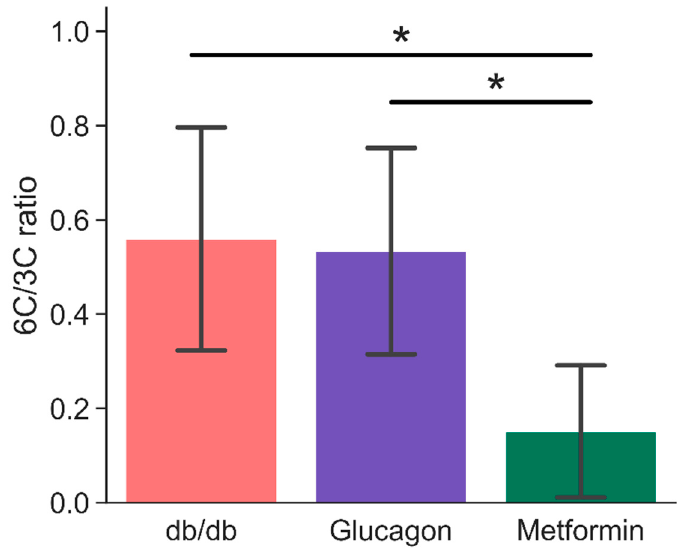
Figure 4. Ratio of signal intensities of six-carbon (glucose-6-phosphate and glucose—both α - and β -isomers) to three- and four-carbon (glyceraldehyde-3-phosphate, phosphoenol pyruvate, glycerol, glycerol-3-phosphate, lactate, and malate) resonances. Signal intensities were obtained by fitting a mixed Gaussian/Lorentzian shape to resonances in the sum spectra (shown in Figure 2). * indicates statistical significance ( p < 0.05). Error bars are standard deviation. n = 6 ( db/db ), 5 (glucagon), and 6 (metformin). 6C/3C ratios were calculated based on observed set of metabolites for each spectrum. Table S1 provides a summary of metabolites observed for each group.